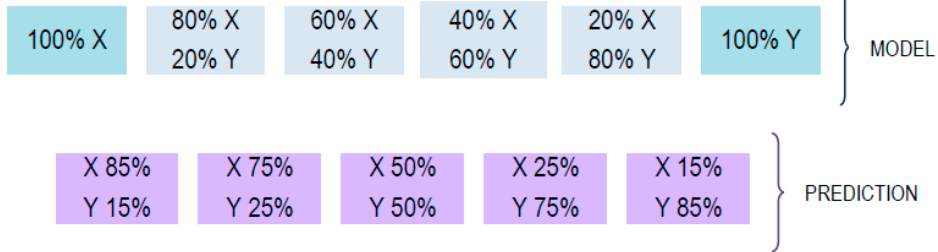
Figure 1. Co ff ee concentration levels employed in the adulteration studies (X original co ff ee sample, Figure 1. Coffee concentration levels employed in the adulteration studies (X original coffee sample, Y co ff ee sample used as Y coffee sample used as adulterant).